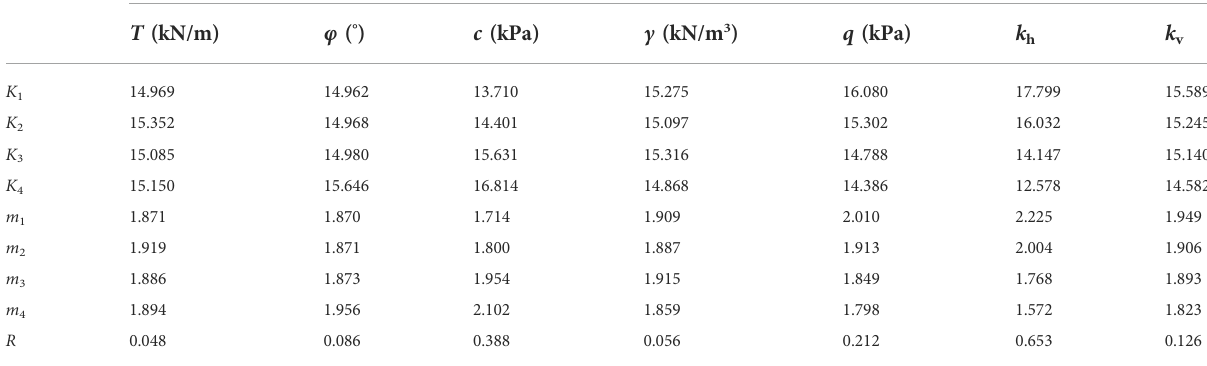
TABLE 4 Range analysis results of the orthogonal test. In fl uence